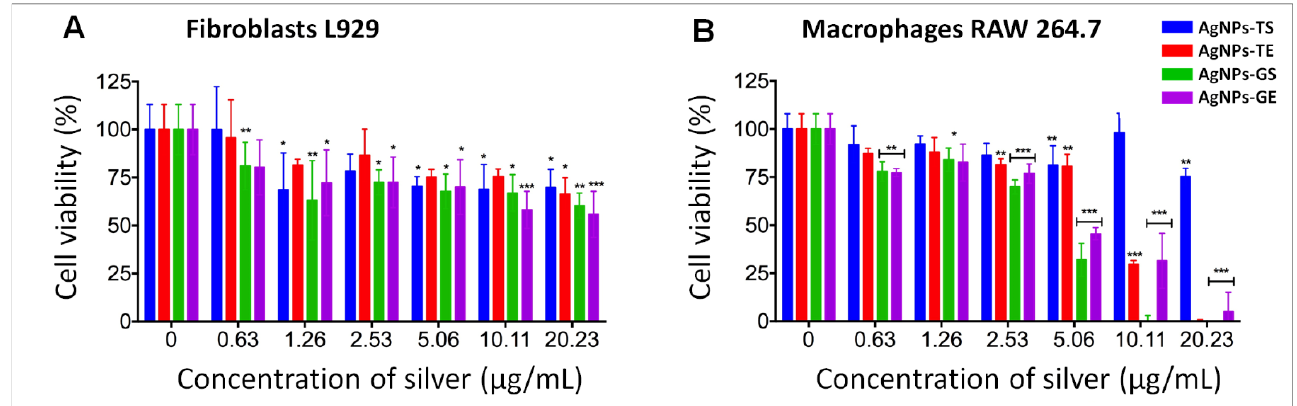
Figure 10. Cell viability assay in fibroblasts ( A ) and macrophages ( B ) exposed to AgNPs synthesized using the supernatant and extract of T. harzianum and G. sessile . The bars represent the mean and standard deviations of experiments performed in triplicate. * p ≤ 0.05, ** p ≤ 0.01, *** p ≤ 0.001.